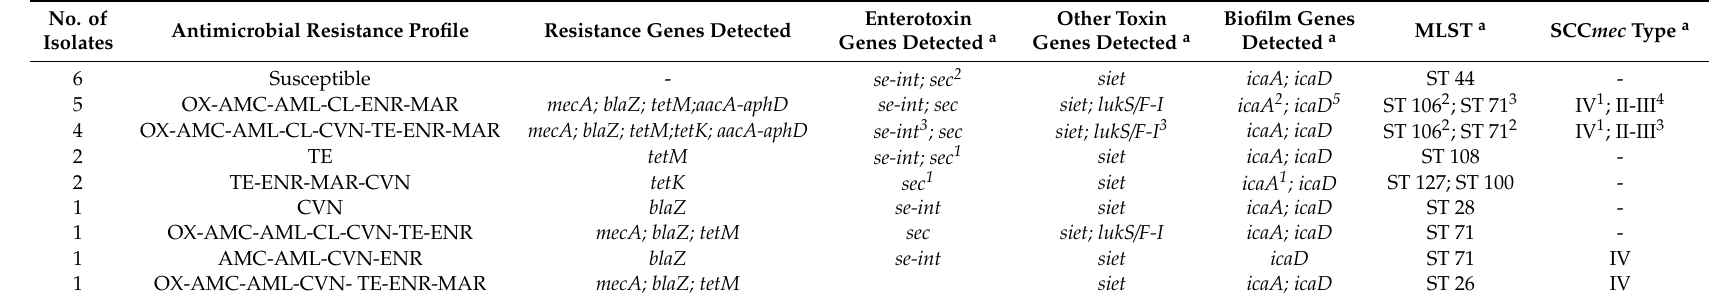
Table 1. Phenotypic and genotypic features of SP